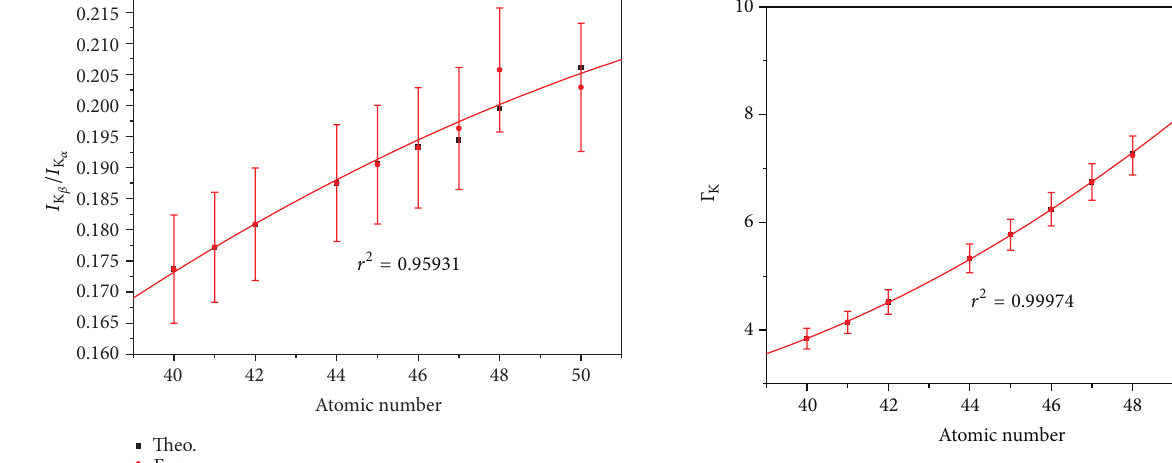
Figure 6: The variation in 𝐼